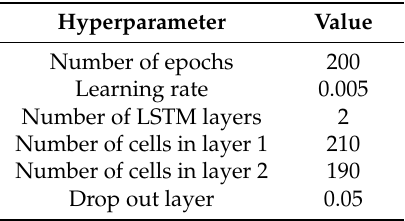
Table 2. The values of the hyperparameters for the